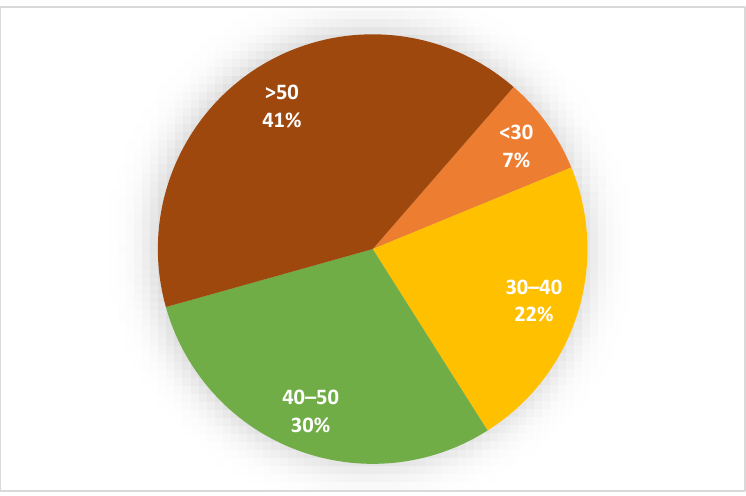
Figure 2. Percentage share of respondents by age group. Table 1. Age of the presenters (data are presented in percentage). Under 50 Years